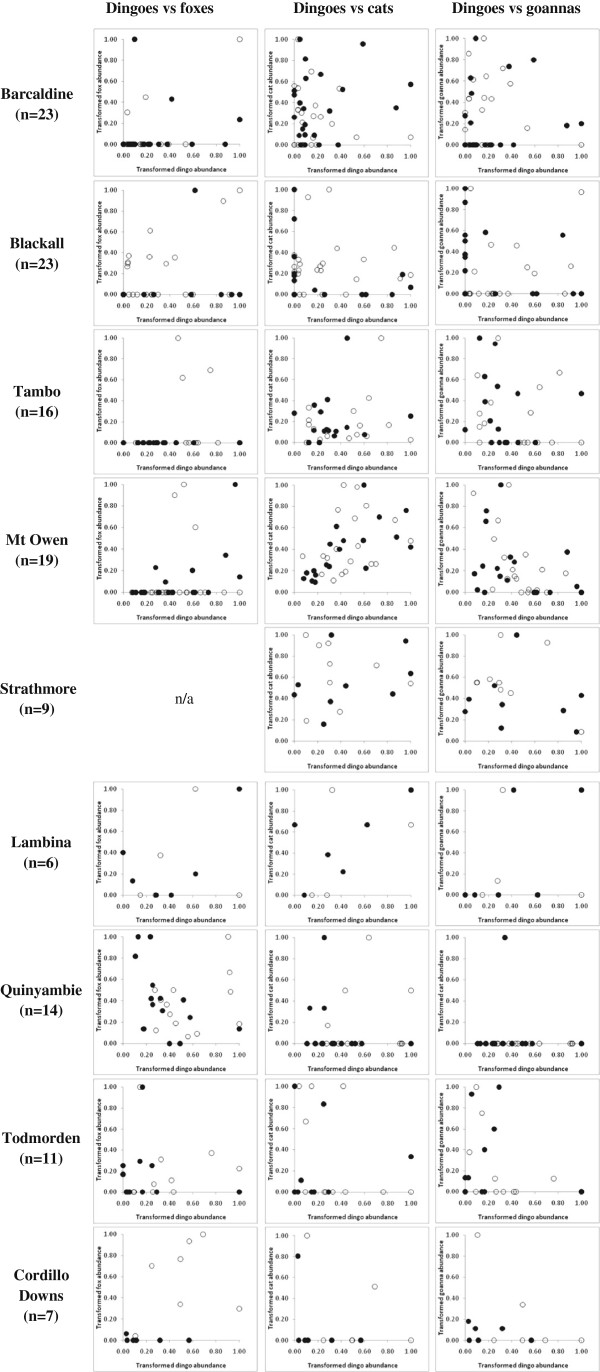
Correlative relationships between dingo and fox, cat and goanna PTI in baited (solid marks) and unbaited (hollow marks) treatment areas at nine sites across Australia, as generated using the approach described by Johnson and VanDerWal [38], showing the typical absence of triangular relationships amongst sympatric predators.